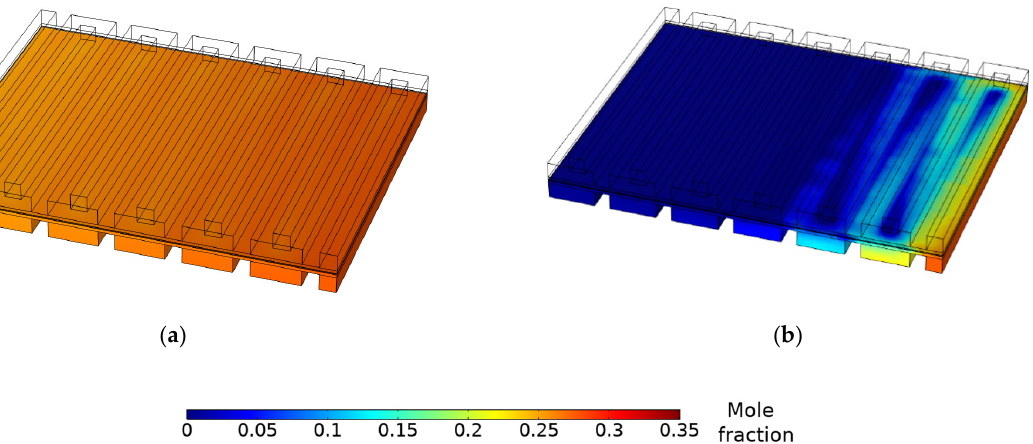
Figure 6. Hydrogen mole fraction distribution at the anode for cell voltage of ( a ) 0.75 V and ( b ) 0.25 V.